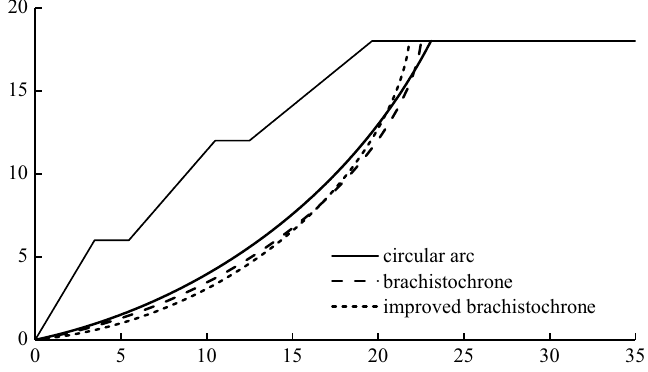
Figure 9. Comparison of sliding surface position as determined by different methods (unit: m).